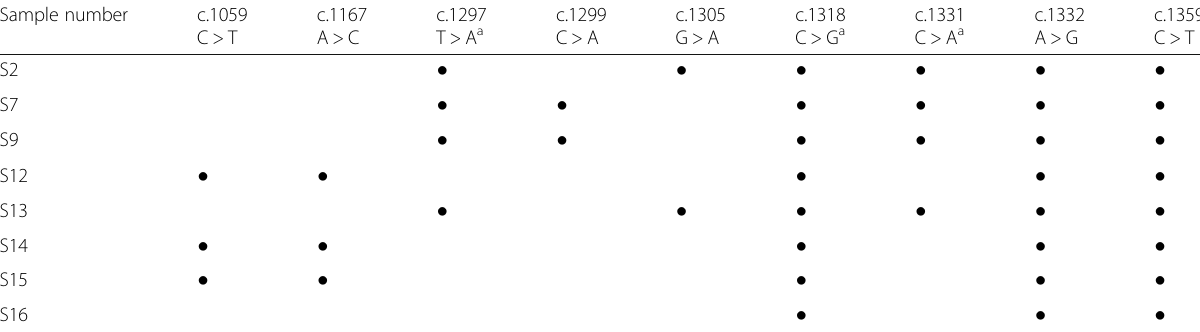
Table 5 Nucleotide changes identified in HPV114-L1 when compared to the reference sequence (GQ244463) in eight HPV114+ samples Sample